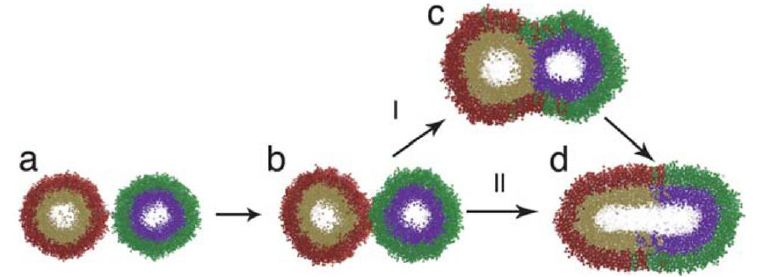
FIGURE 2. Model of membrane fusion. Two unfused lipid bilayers (a) form a stalk (b). This intermediate formation can advance to a hemifused state (pathway I; c) before